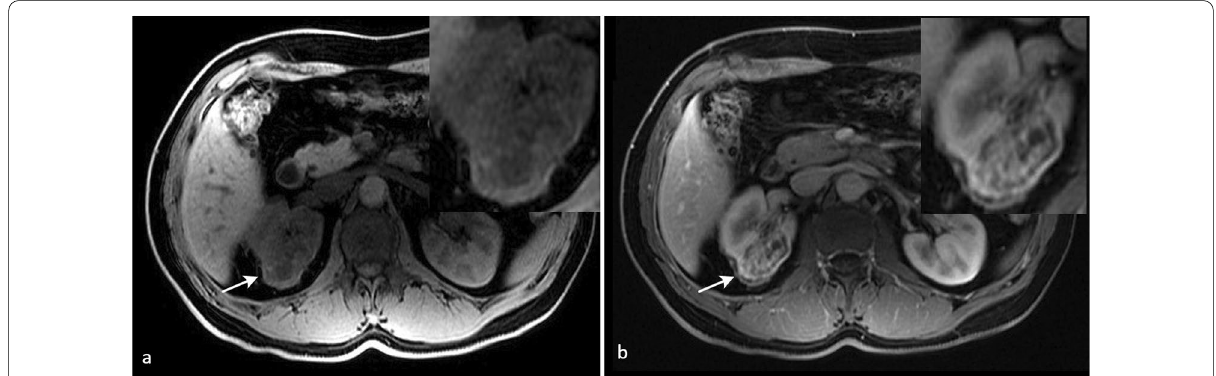
Fig. 3 Follow-up MRI at 3 months. a T1WI sequence showing regions of hyperintensity in the cystic space (proteinaceous material). b Contrast-enhanced axial T1-weighted sequence, in arterial phase, showing cyst’s thickened wall (arrow)